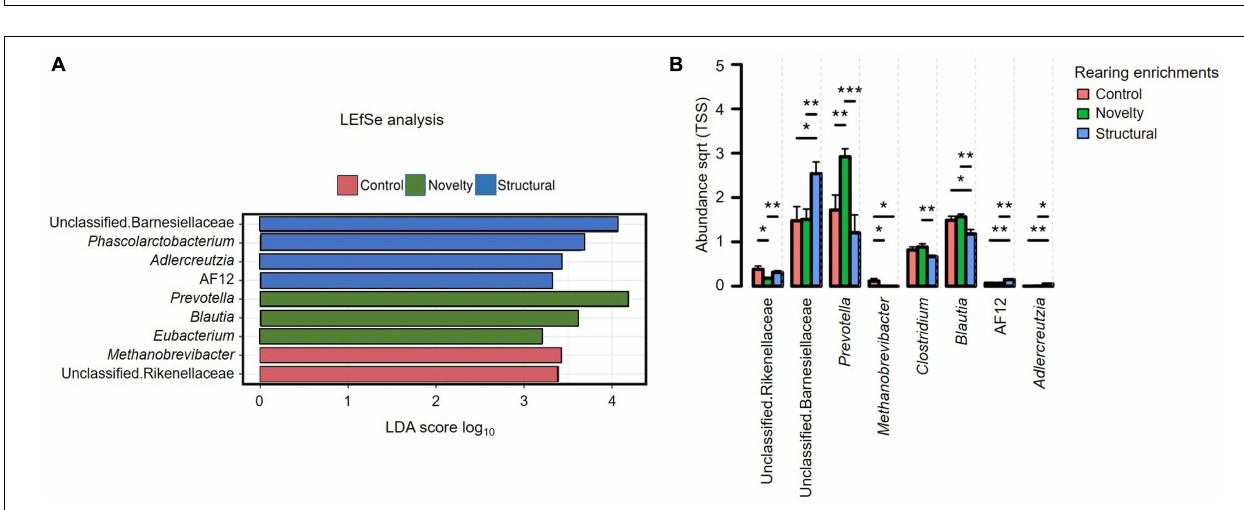
FIGURE 2 | (A) Relative abundance of cecal microbiota of pullets at 15 weeks of age from different rearing enrichments (control, novelty, structural) showing linear discriminant analysis (LDA) effect size method (LEfSe). (B) Differences in the relative abundance of cecal microbiota of pullets at 15 weeks of age from different rearing enrichments (control, novelty, structural) at genus level. One-way ANOVA followed by post hoc comparisons between rearing enrichment groups showed differences * P ≤ 0.05, ** P ≤ 0.01, *** P ≤ 0.001.